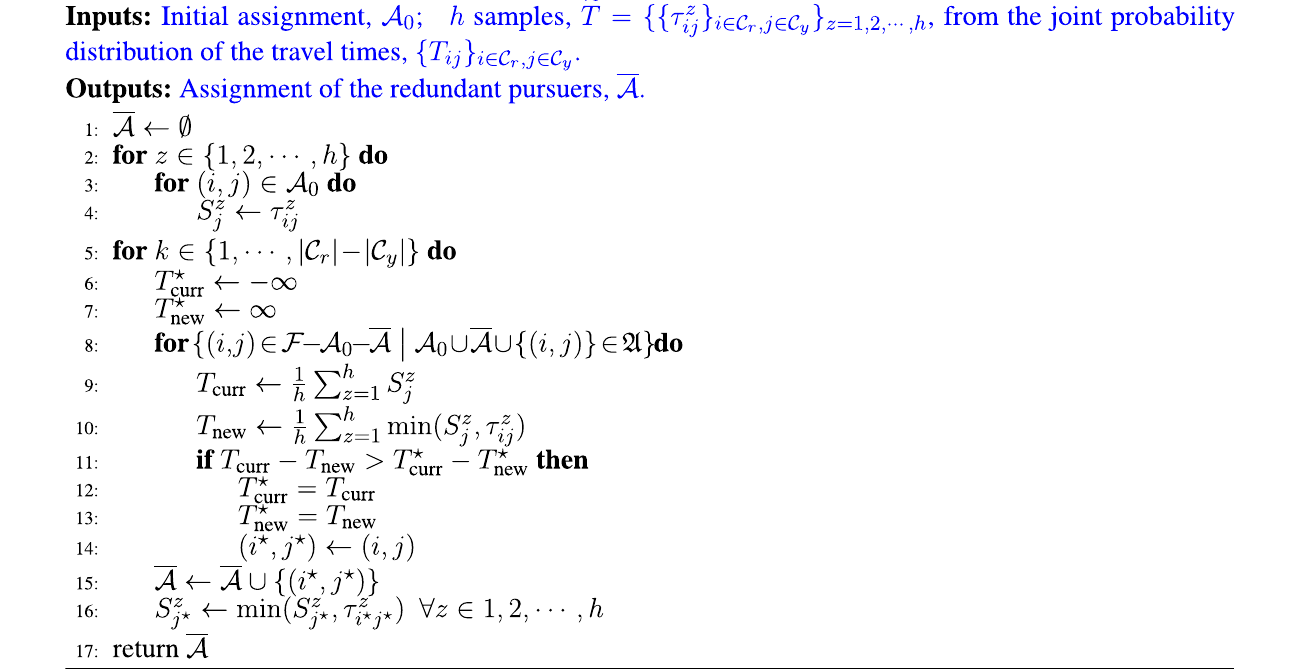
Algorithm 2 summarizes our greedy redundant assignment algorithm. At the beginning of the algorithm, we sample h |